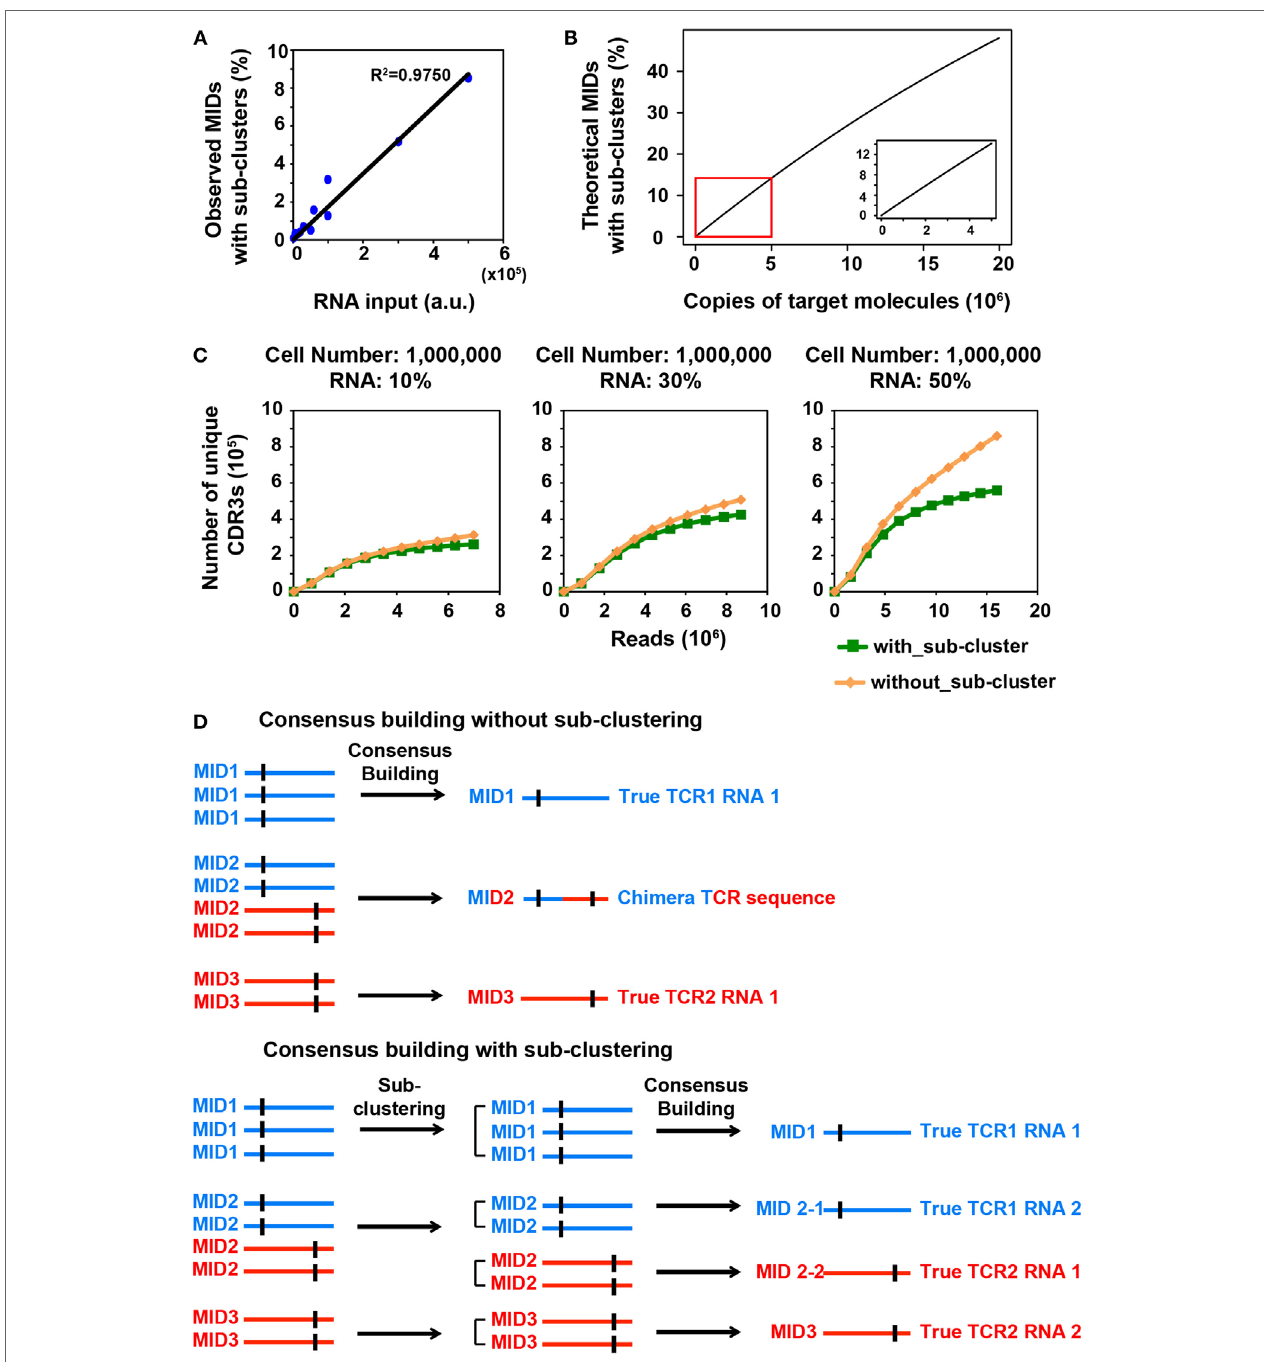
FIGURe 1 | MID Clustering-based IR-Seq improves accuracy of T cell receptor (TCR) diversity estimation with sub-clustering. (A) The percentage of observed molecular identifiers (MIDs) containing sub-clusters is linearly dependent on RNA input, which is defined as cell number multiplied by percentage of RNA (e.g., 20,000 cells with 10%RNA is equivalent to 2,000 RNA input). Line represents linear regression fit, F -test on the slope, p < 10 − 9 . (B) The theoretical percentage of MIDs with sub-clusters is approximately linearly dependent on copies of target molecules when copies of target molecules are less than 5,000,000 (bottom right insert). The theoretical percentage of MIDs with sub-clusters was calculated by Eq. 2 in Section “Materials and Methods.” (C) Rarefaction curve of unique complementarity-determining regions 3 (CDR3s) with or without sub-clustering. Number of unique CDR3s in three libraries made with three different RNA inputs from sorted one million naïve CD8 + T cells are shown here. Data from other cell inputs are in Figure S2 in Supplementary Material. (d) Illustration of consensus TCR sequence building without (top) and with (bottom) sub-clustering. Top: without sub-clustering, chimera sequences are generated when different TCR RNA molecules are tagged with the same MID; bottom: TCR RNA molecules that are tagged with same MID are sub-clustered to reveal truly represented TCR sequences. Short vertical black lines indicate nucleotide differences between two TCR sequences.